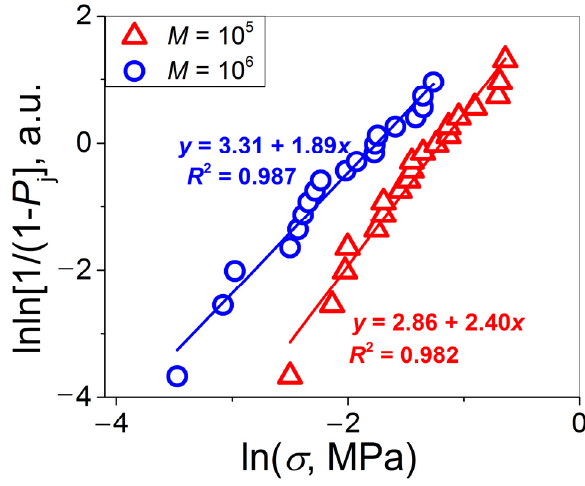
Figure 3. Weibull plots for the data presented in Figure 2a.